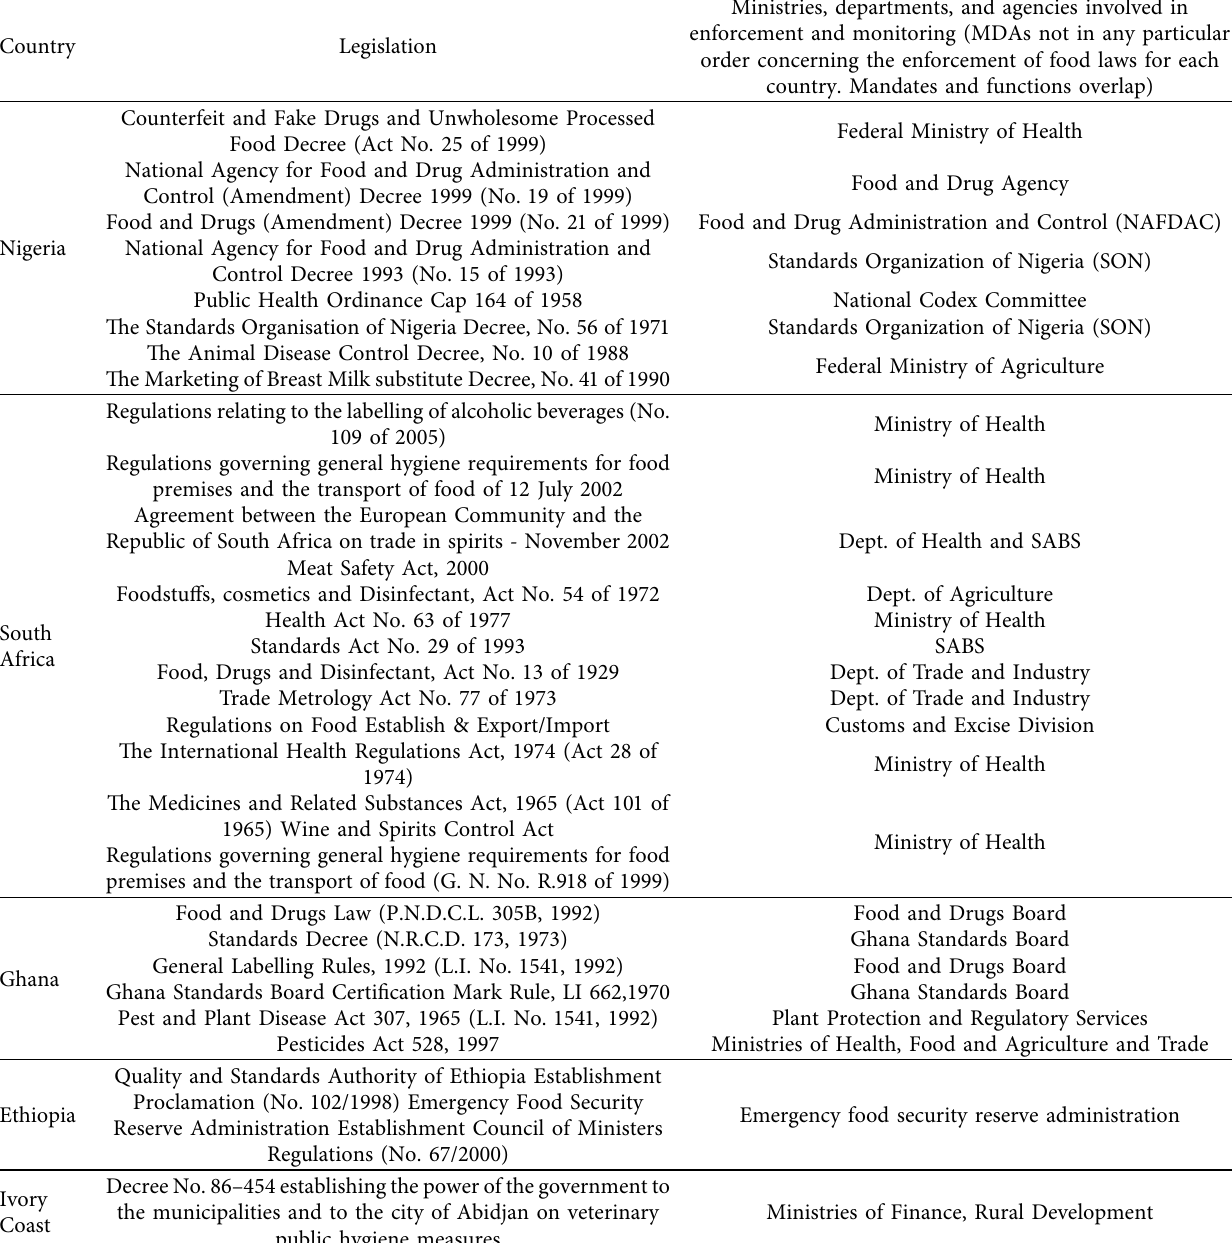
Table 4: Food safety legislation in some developing countries (Nigeria, South Africa, Ghana, Ethiopia, and Ivory Coast) [215].